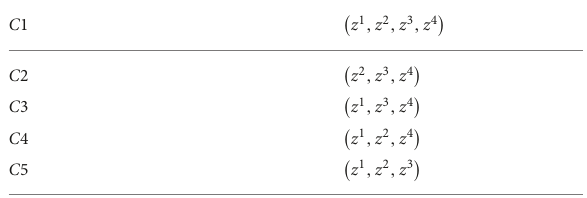
TABLE 5 Feature combinations.